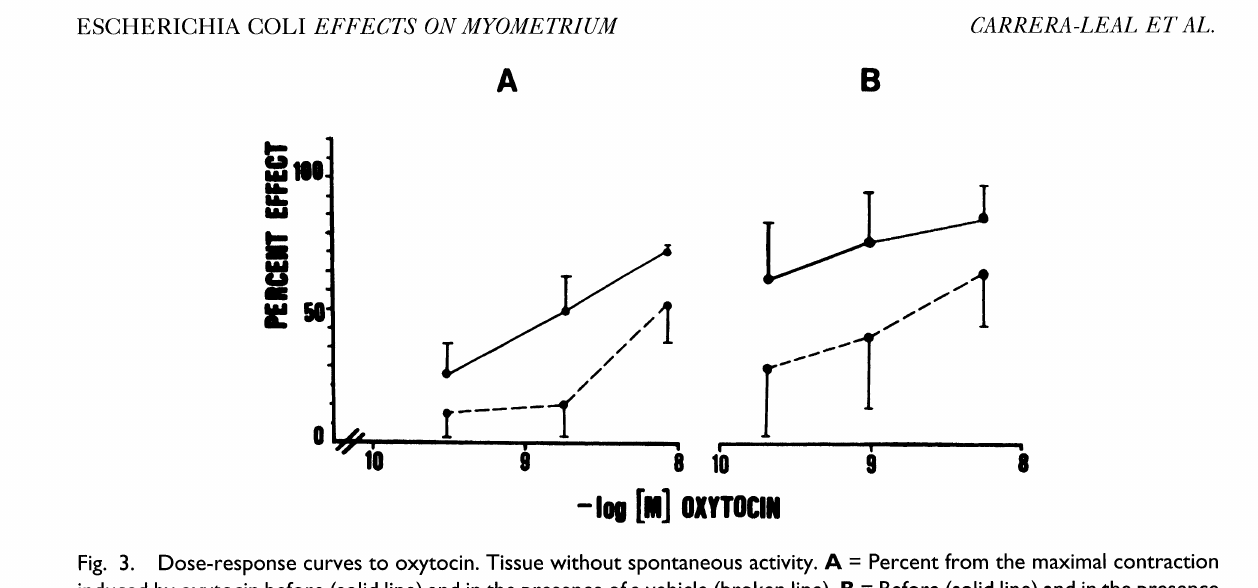
Fig. 3. Dose-response curves to oxytocin. Tissue without spontaneous activity./, Percent from the maximal contraction induced by oxytocin before (solid line) and in the presence of a vehicle (broken line). B Before (solid line) and in the presence of toxin (broken line) (X +